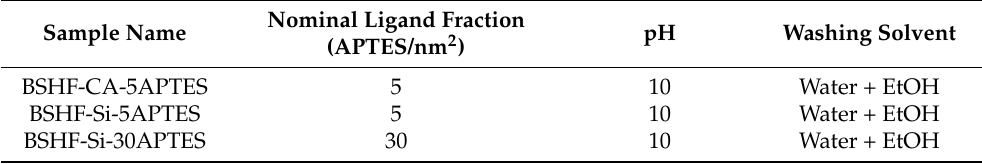
Table 1. Experimental conditions for coating the BSHF NPLs with APTES.